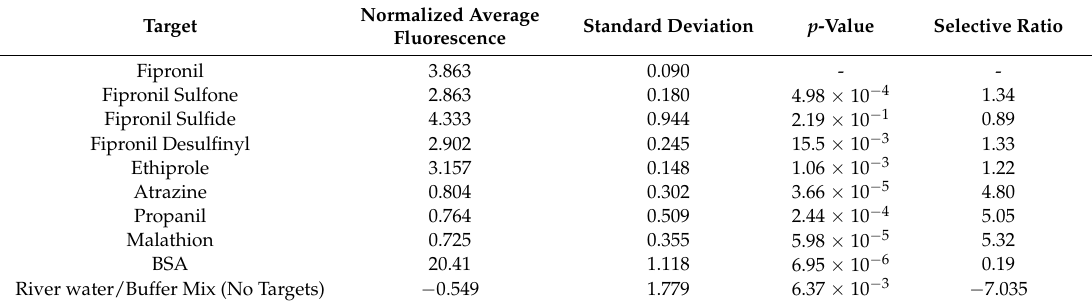
Table 3. Cross-reactivity data of R12.51 ssDNA MRE in river water/buffer mix. Normalized Average Target